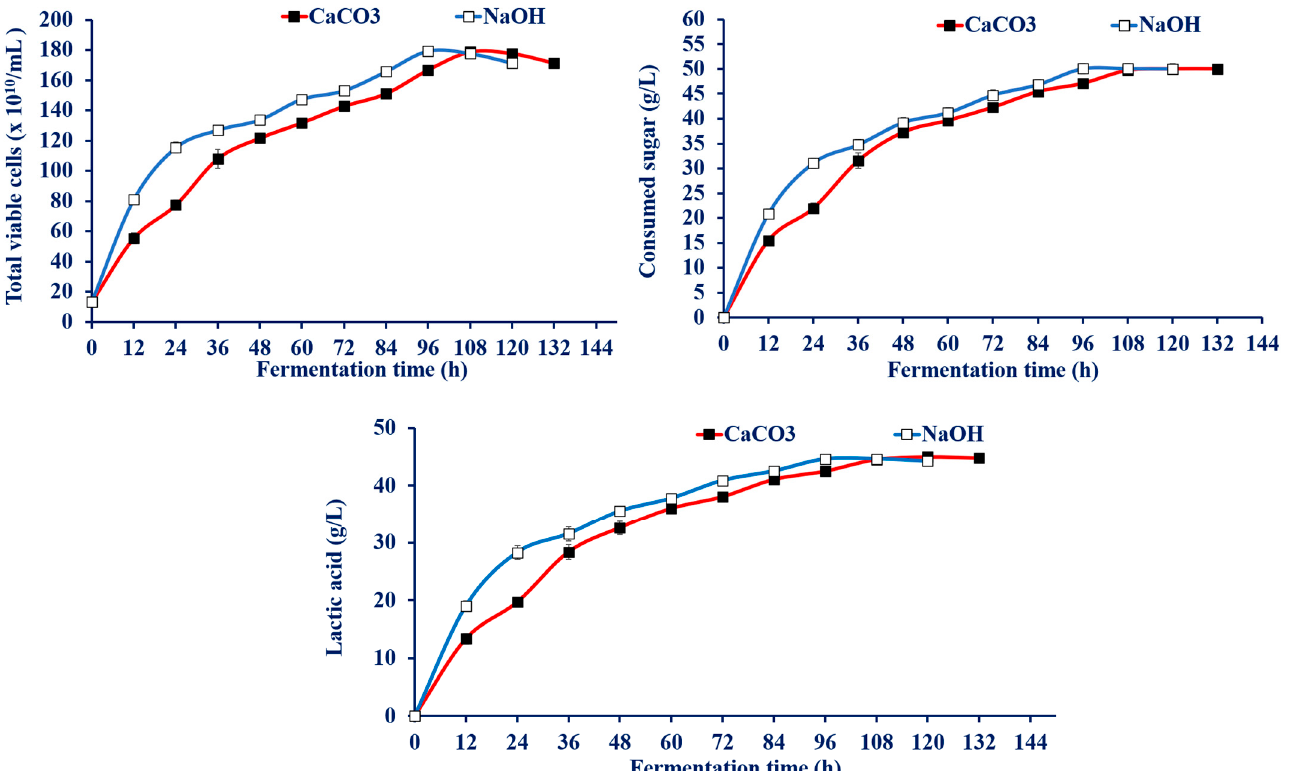
Figure 4. Effect of different neutralizing agents on LA production by E. faecium WH51-1. The standard deviation is less than the size of symbols if no error bars are seen.